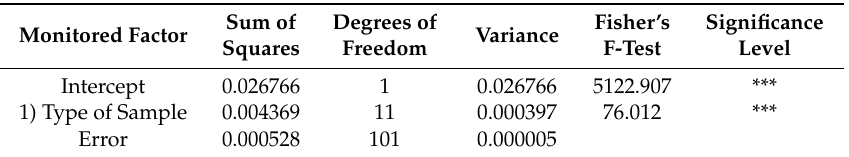
Table 8. Statistical evaluation of the e ff ect of the factors and their interaction on the coe ffi cient of wood bendability ( K bendB ) for aspen and NWC on top.